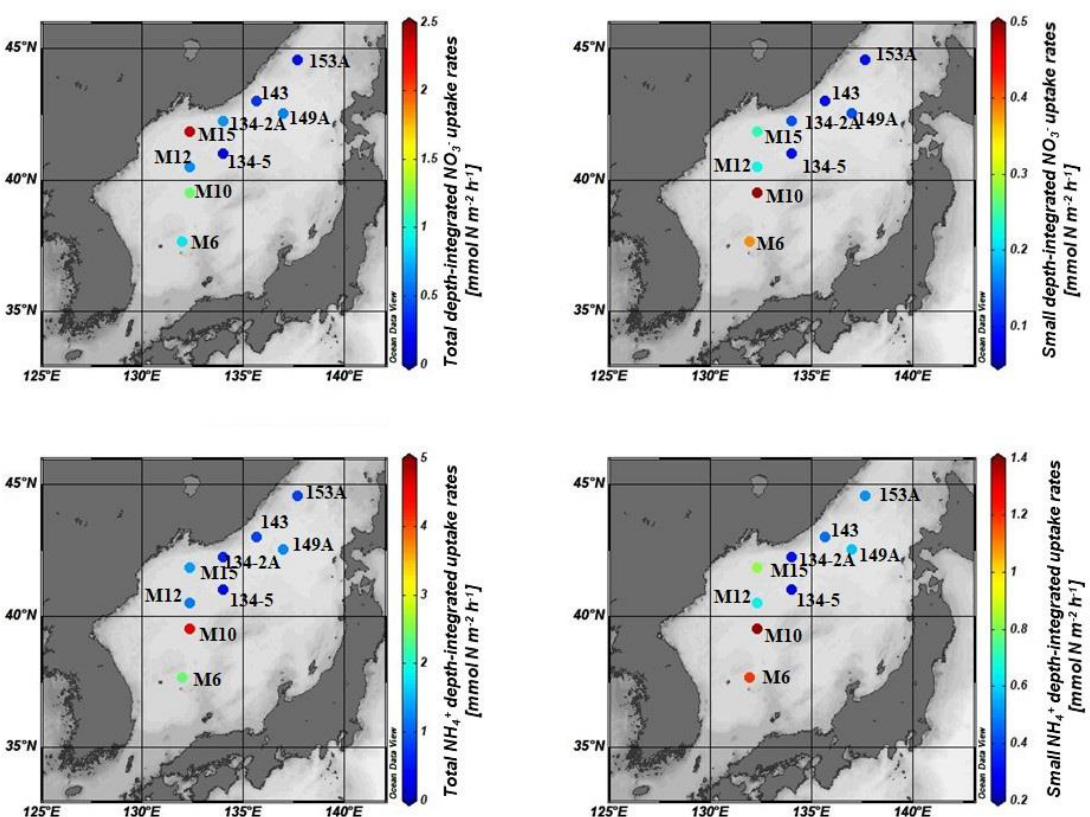
Figure 6. The depth-integrated total and small phytoplankton NO 3 − and NH 4 + uptake rates in the East / Japan Sea during 2015.